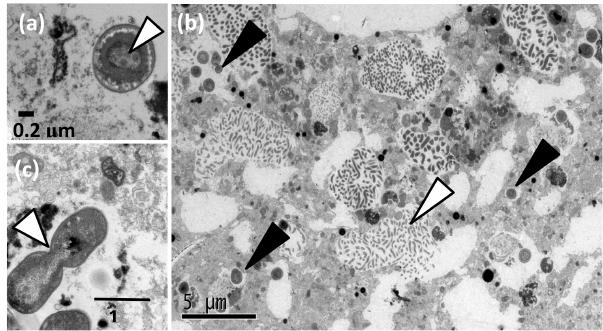
Figure 5. Transmission electron microscope images of Synechococ- cus cells inside G. bulloides. (a) A Synechococcus cell with charac- teristic polyhedral carboxysomes in the central cytoplasmic region (white arrow) surrounded by thylakoid membranes. (b) Numerous Synechococcus cells within a G. bulloides cell are observed in both the cytoplasm and vacuoles (black arrow). This is a region of cyto- plasm rich in fibrillar bodies (white arrow) found only in planktonic foraminifera, and whose function is unknown. (c) Synechococcus cell within a G. bulloides cell undergoing cell division as indicated by the presence of a constriction at the cell midpoint (white